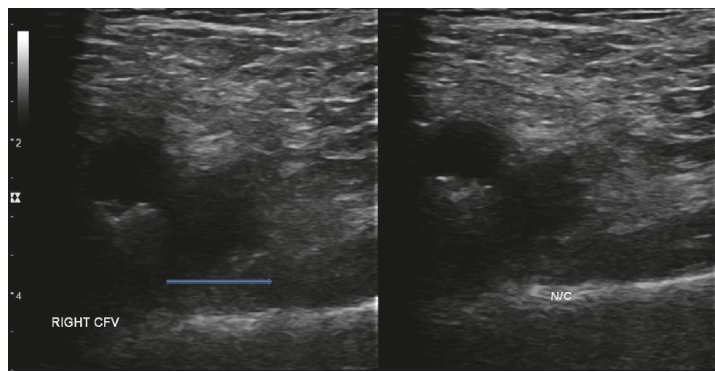
Figure 1: Noncompressibility of right common femoral vein (CFV) seen on duplex ultrasound.